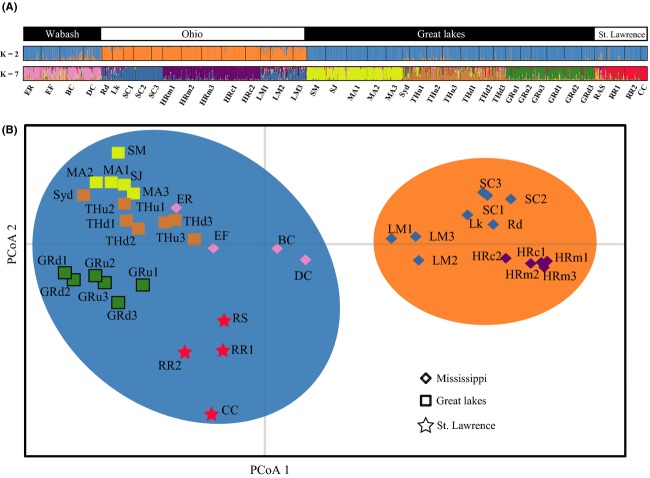
Range-wide genetic structure analysis of the Eastern Sand Darter; Panel (A): results of STRUCTURE analysis using 39 sample sites from 16 rivers across species range. STRUCTURE simulation summary for each sample site, with different colors showing each genetic cluster at K = 2 and K = 7, respectively. Panel (B): principle coordinate analysis (PCoA) performed using pairwise FST among all sampled sites across the species range. The range was separated into three drainages: St. Lawrence, Great Lakes, and Mississippi (combination of Wabash and Ohio drainages). The proportion of genetic variance explained by the first two axes is 62.7%.